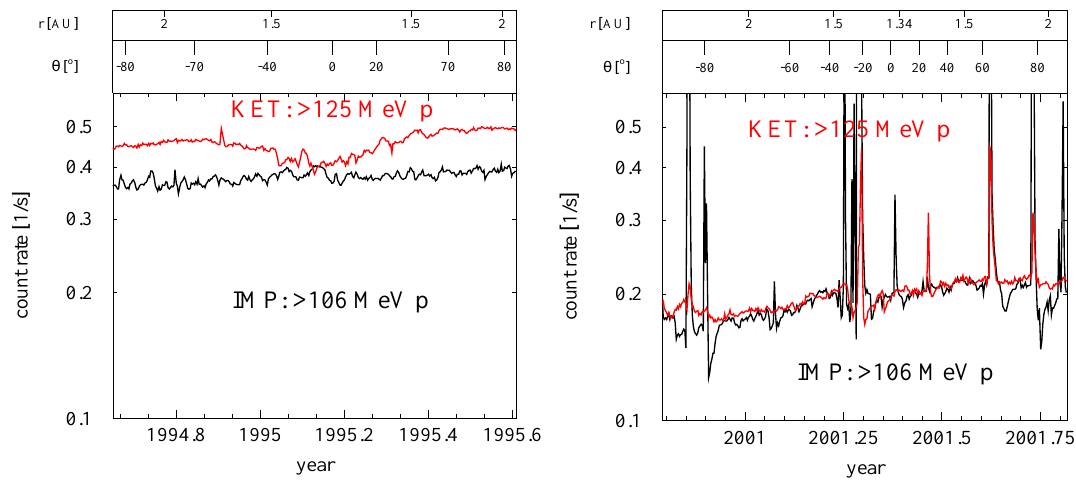
Fig. 8. Daily averaged time profile of > 106 MeV and > 125 MeV protons at Earth and Ulysses for the first and second latitude scan.